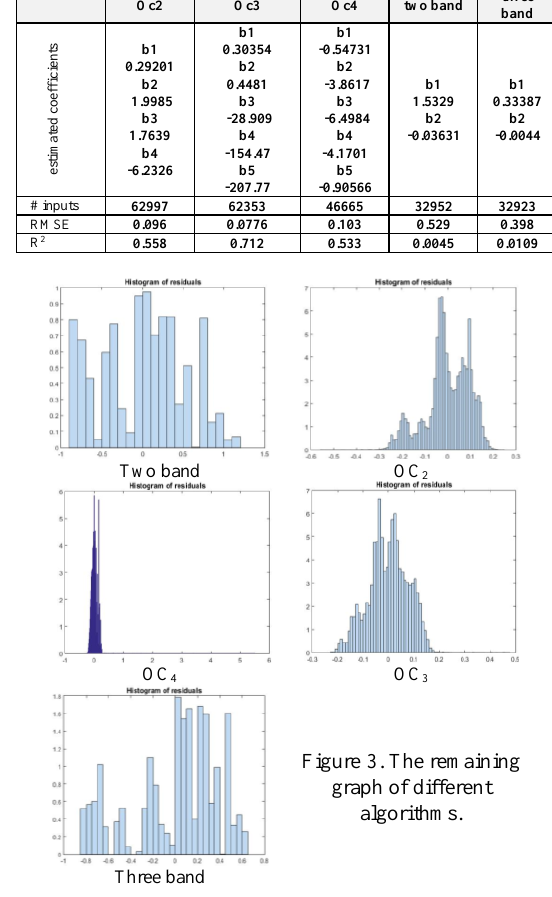
Figure 1. The Persian Gulf region and the study area